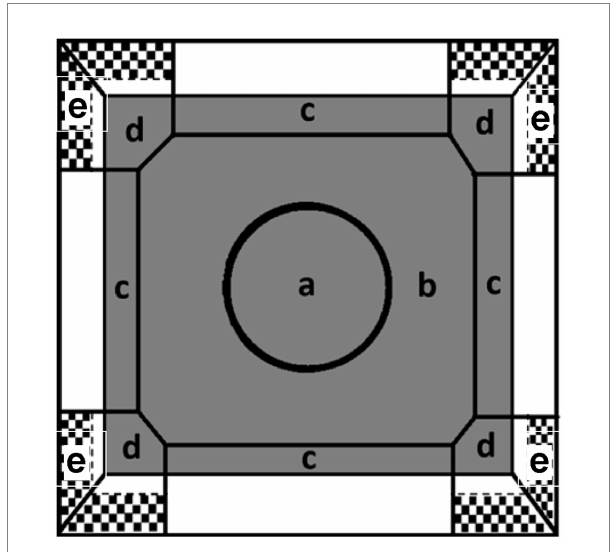
FIGURE 1 The illustration of each zone in the OF task. (a) Center zone, (b) peripheral zone, (c) edge zone, and (d) corner zone. An additional rearing zone was defined on the upper wall in the corner